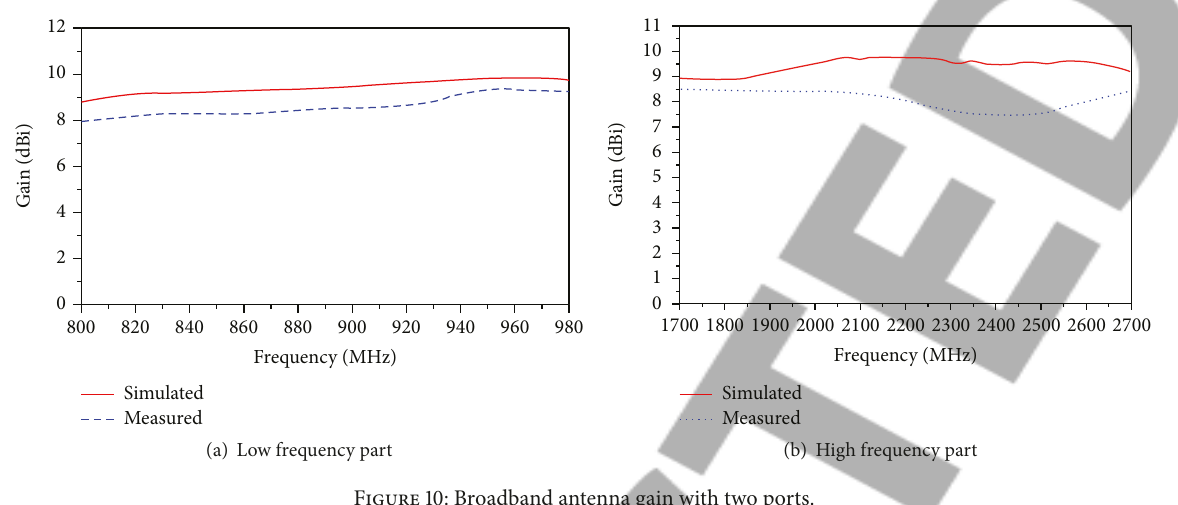
Figure 10: Broadband antenna gain with two